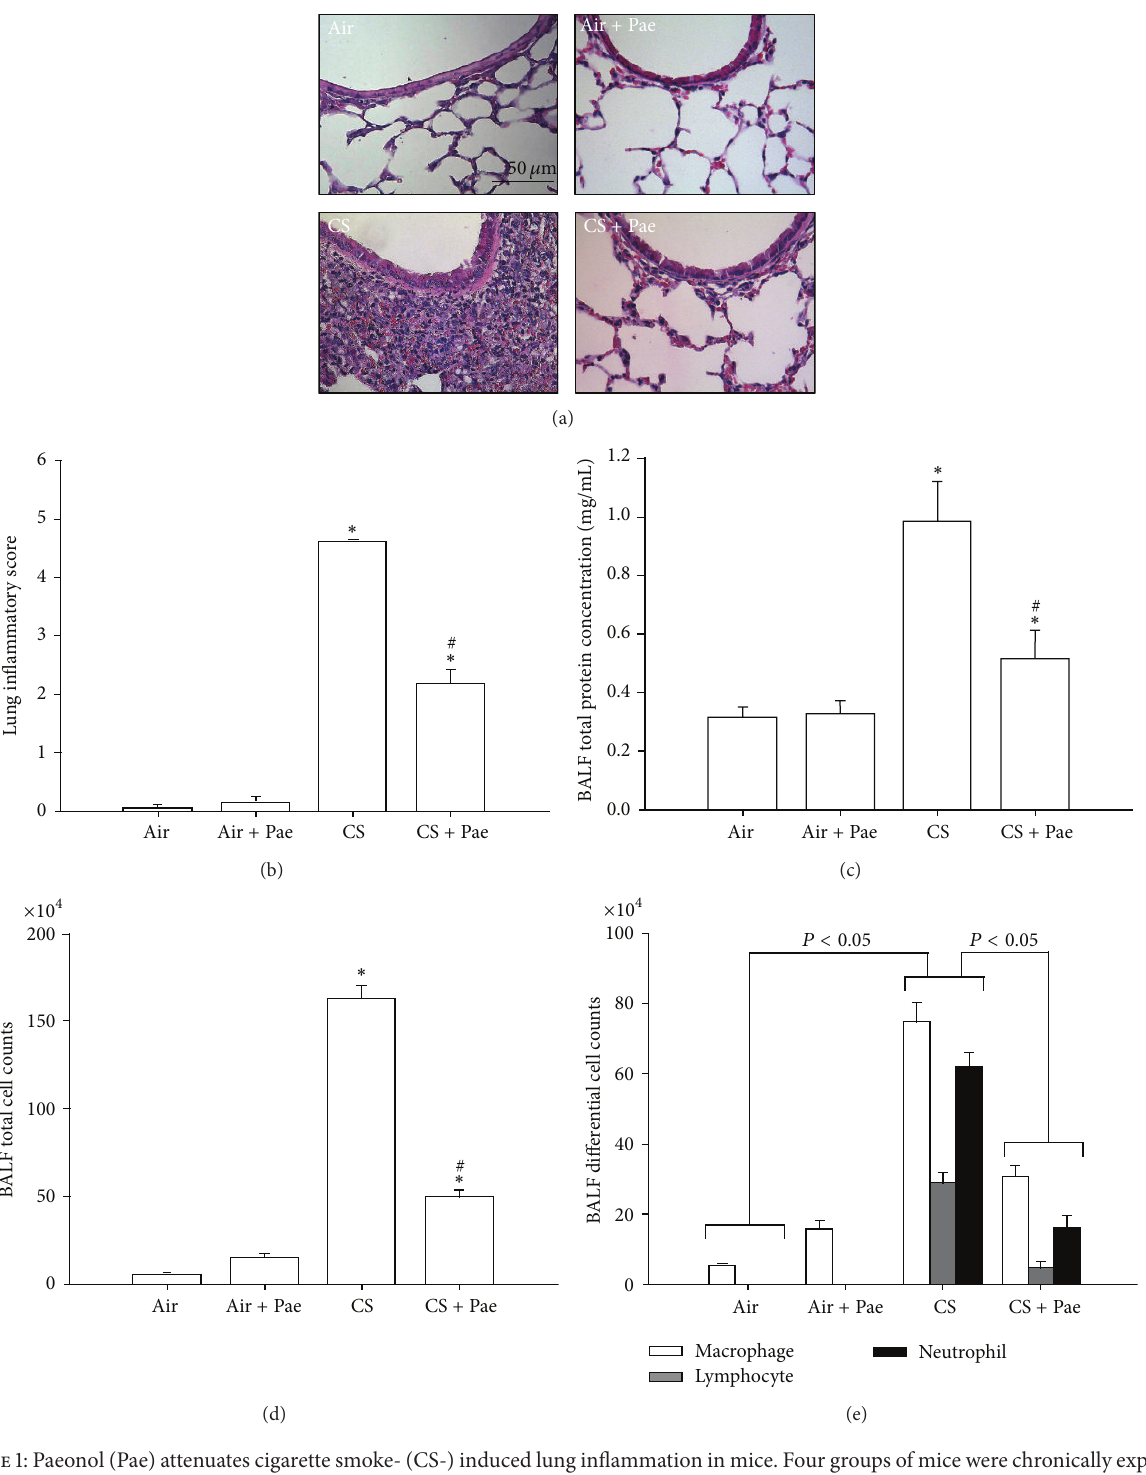
Figure 1: Paeonol (Pae) attenuates cigarette smoke- (CS-) induced lung inflammation in mice. Four groups of mice were chronically exposed to air or CS for 4 weeks. Two of the four study groups received daily treatment with paeonol (10mg/kg body weight) or saline (vehicle control) by gastric gavage during the 4-week exposure. (a) Representative images of H&E stained lung sections. (b) Lung inflammatory scores were calculated according to the sum of the levels of cell infiltration and damage levels as assessed from the lung sections. ((c)–(e)) Total protein content, total cell count, and differential cell count in bronchoalveolar lavage fluid (BALF) were measured and served as indications of lung inflammation. Data in each group are mean ± SEM from 7 mice. ∗ 𝑃 < 0.05 versus the air-exposure group; # 𝑃 < 0.05 versus the CS-exposure group with vehicle